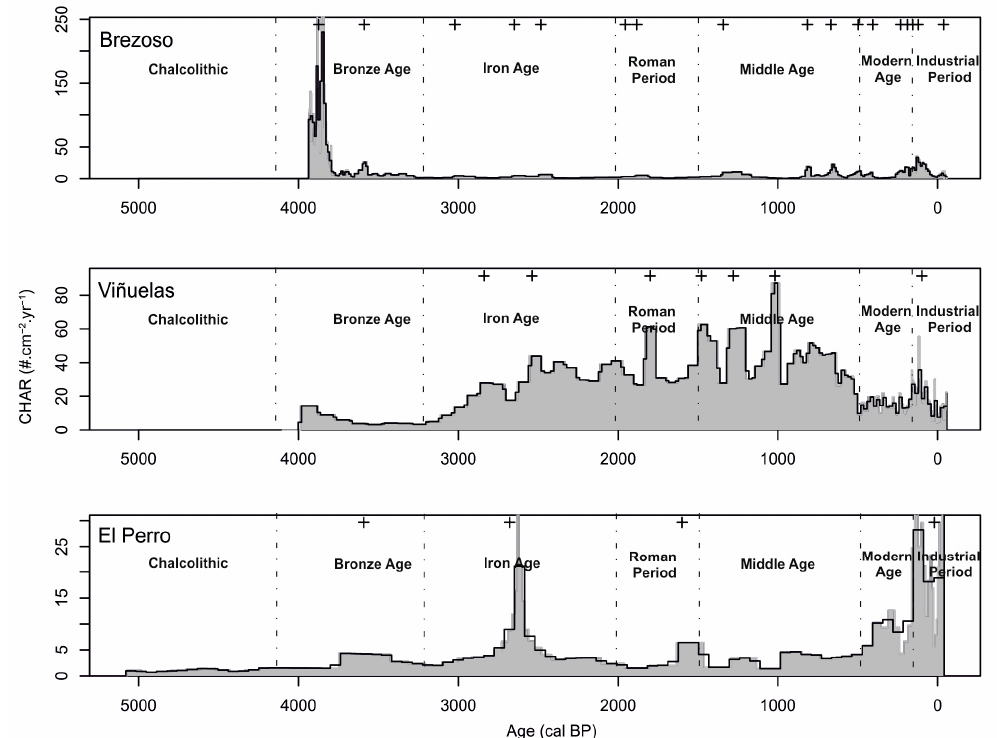
Figure 3. Charcoal accumulation rates (CHAR) and robust fire events for ( top ) Brezoso, ( middle ) Viñuelas, and ( bottom ) El Perro mires. “ + ” denotes statistically robust fire events. The grey areas correspond to raw charcoal data while the black lines correspond to CHAR interpolated to the median resolution of the records. Note the di ff erent scale of the Y axes.